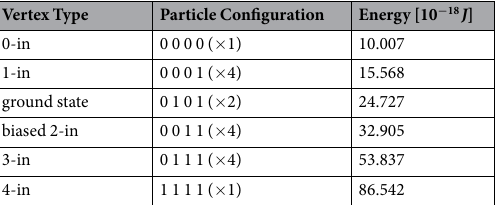
and F ppc , and for the 3-in end, ,1 ,1